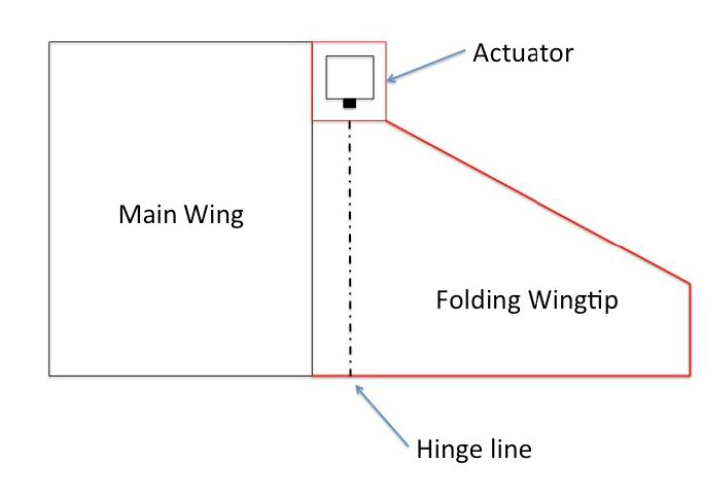
Figure 1. Hinge Line Actuator.